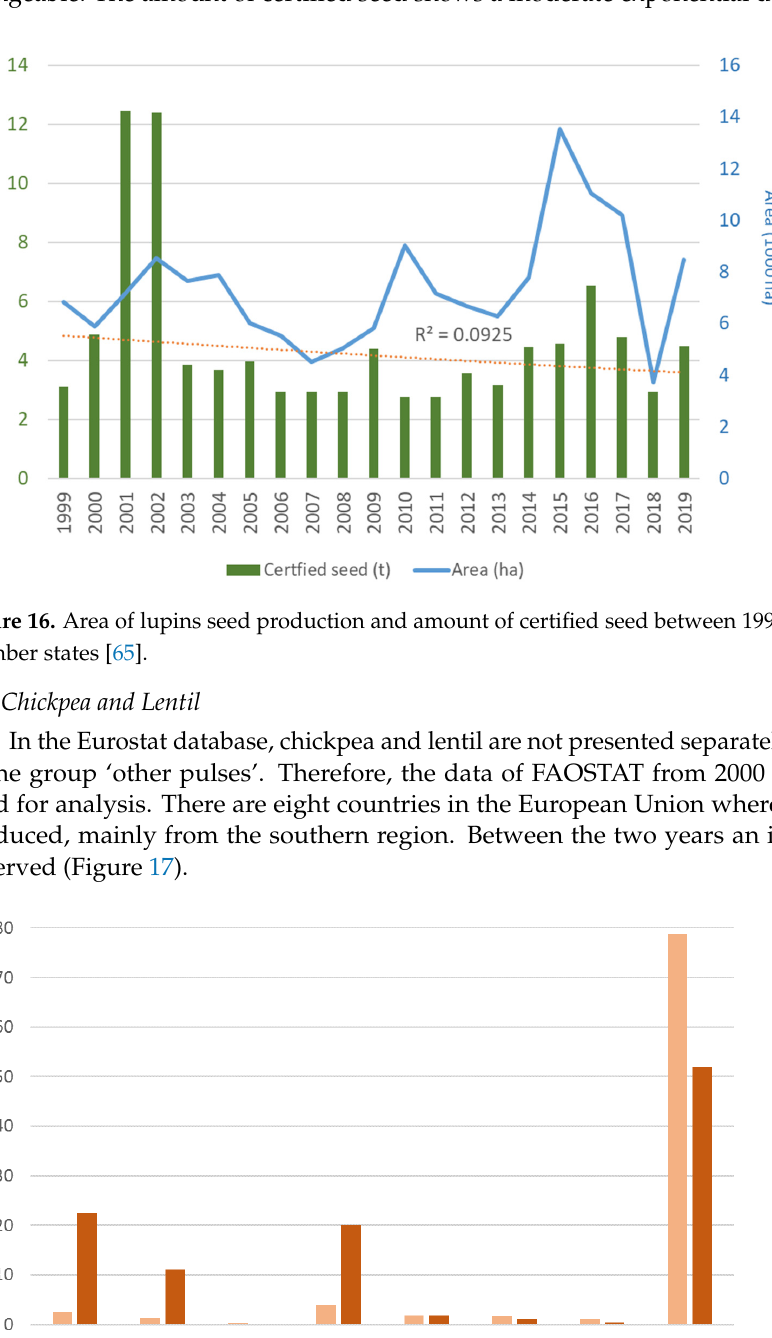
Figure 15. Number of white lupin varieties according to registration year from the national variety lists of the EU member states [47–64].